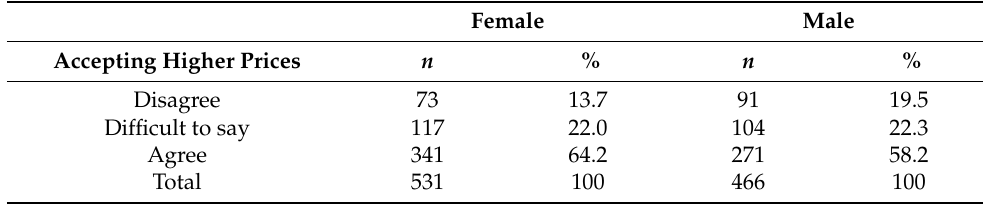
Table 1. Acceptance of higher prices for products that do not cause environmental damage in the female and male groups.